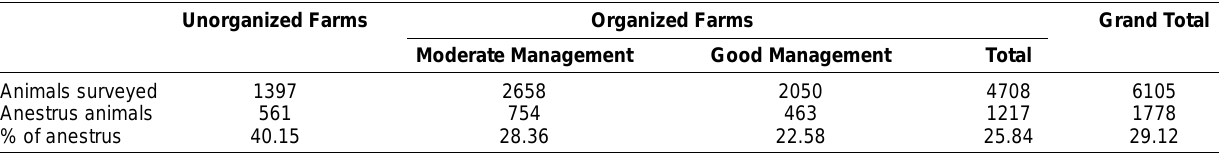
Table-2. Incidence of anestrus under different rearing system